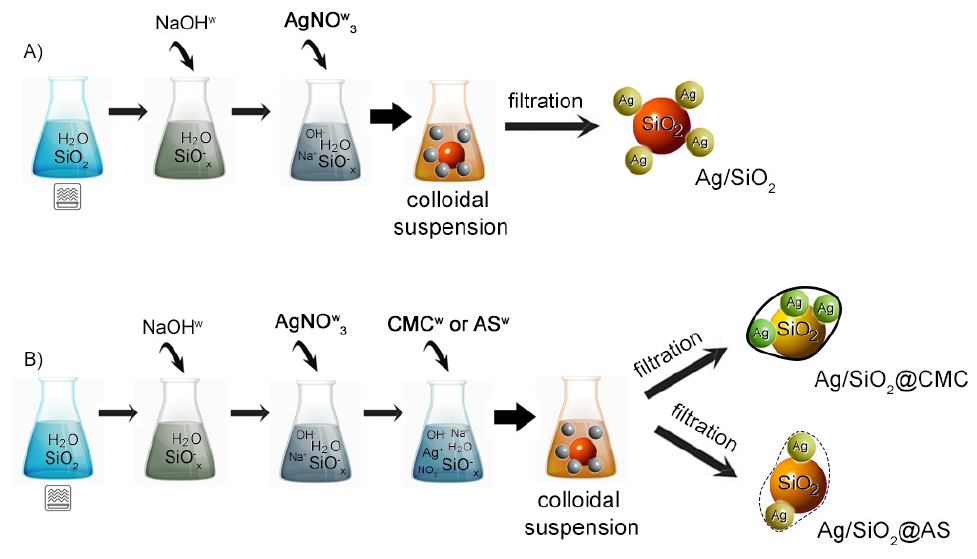
Figure 1. Two synthesis routes ( A , B ) were considered to fabricate the powder ( A ) silver-silica nanocomposite and ( B ) its derivatives.